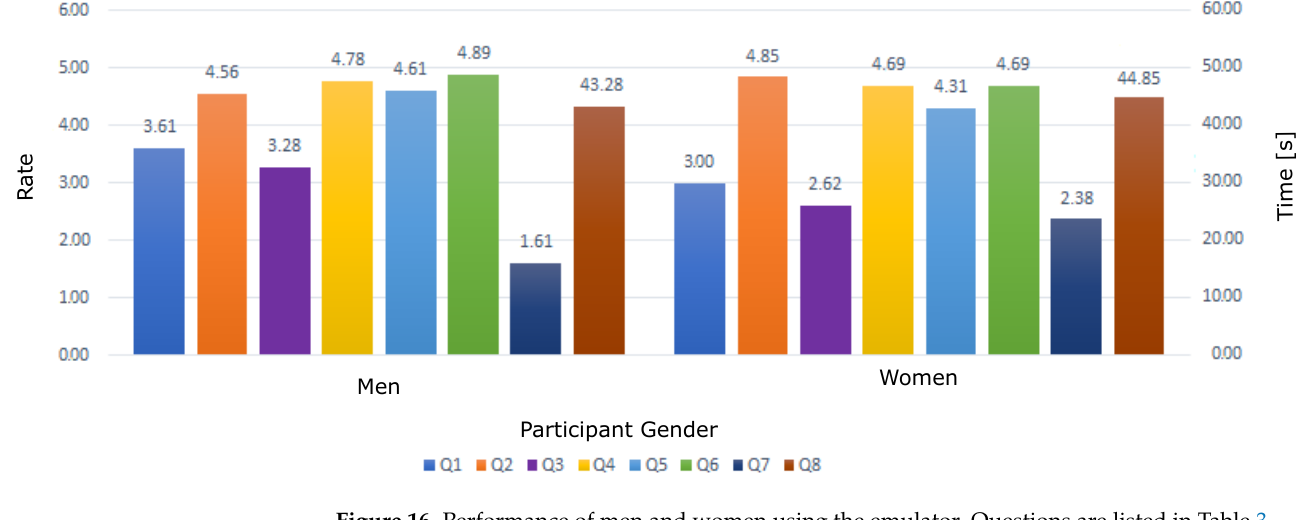
Figure 16. Performance of men and women using the emulator. Questions are listed in Table 3.